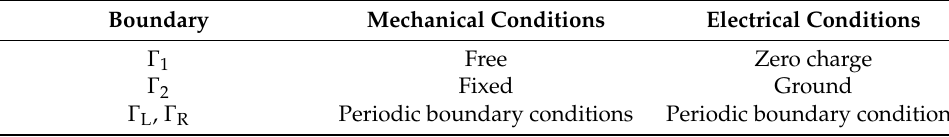
Table 4. Boundary conditions used in the simulation model.